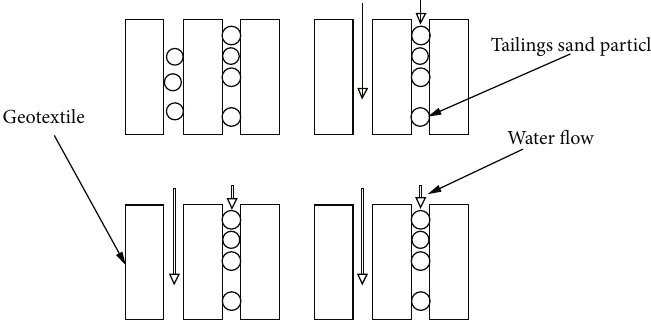
Figure 17: Schematic diagram of the increase of tailing sand particles in water fl